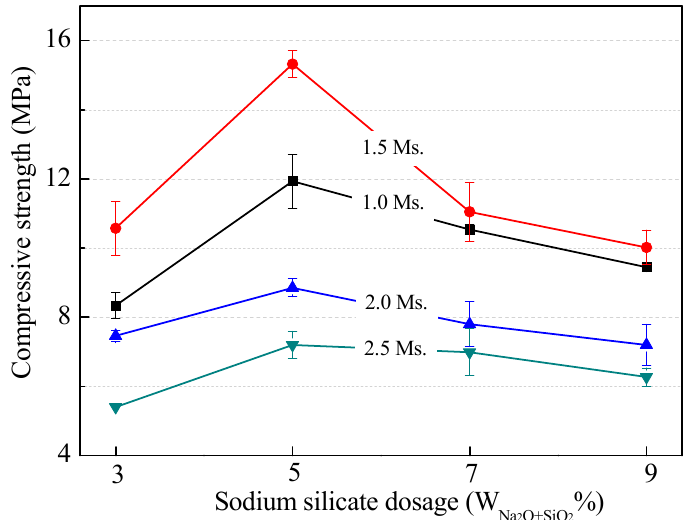
Figure 5. The UCS variation of the geopolymer matrices with different modulus and dosages of sodium silicate.